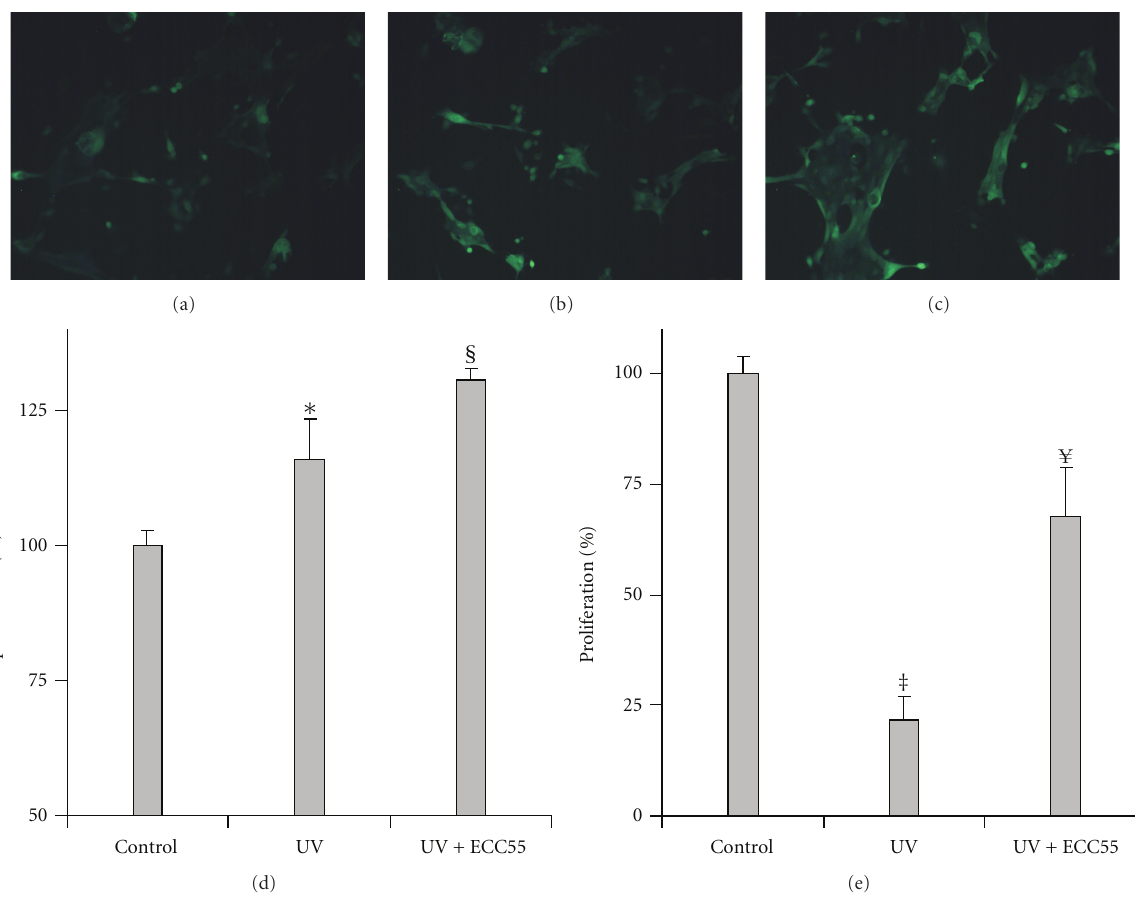
Figure 1: E ff ects of concentrated ethanol extract of Edelweiss callus cultures (ECC55) on UV-induced keratinocyte damage and intracellular nitric oxide (NO) production. Fluorescent microphotographs of the control untreated keratinocytes (a), keratinocytes 1h after irradiation by solar simulating UVA+UVB (b), and keratinocytes pretreated with 25 μ g/mL of ECC55 for 30min and then subjected to UVA+UVB exposure (c). Quantification of intracellular fluorescence of NO-specific fluorescent probe DFA-DA (d). Keratinocyte vitality assessed by MTT test. Error bars in all figures correspond to S.D. ∗ P < 0.05 versus sham-irradiated control; § P < 0.05 versus UV irradiation without ECC55; ‡ P < 0.01 versus sham-irradiated control; (cid:2) P < 0.01 versus UV irradiation without